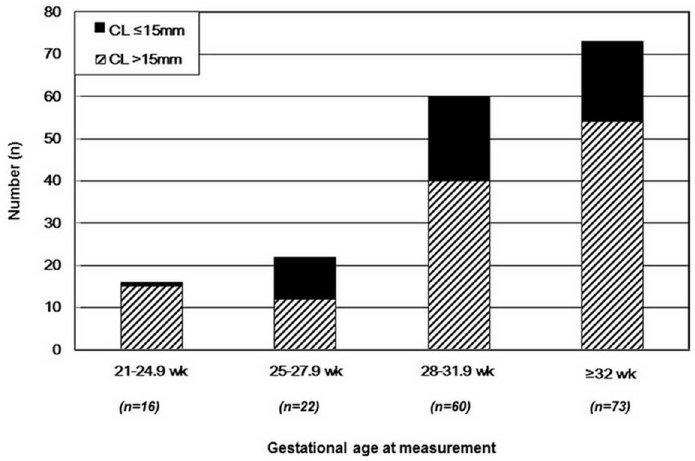
Fig 1. Frequency of a short cervix and normal cervicallength stratified by gestational age at measurement (P = 0.052 for χ 2 test across 4 groups). Closedcolumns represent a short cervix. Hash- marked columns representnormal cervical length.